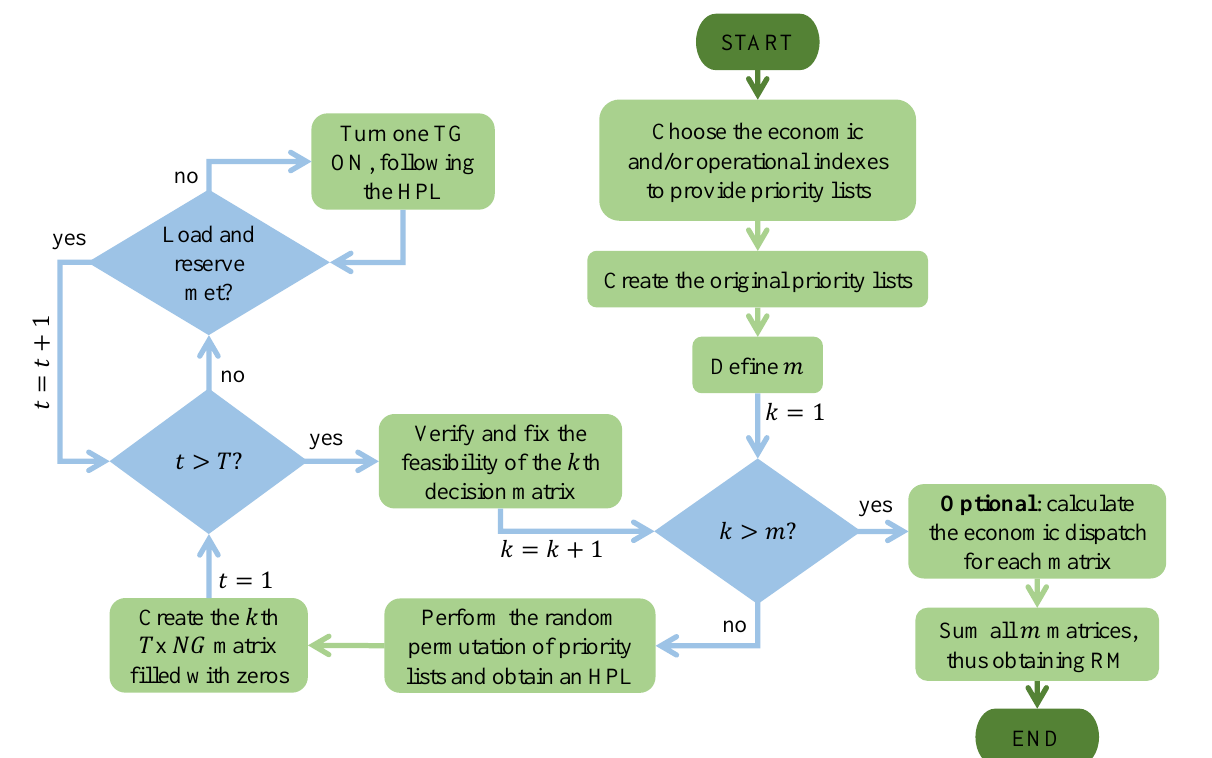
Figure 2. Flowchart describing the proposed method.